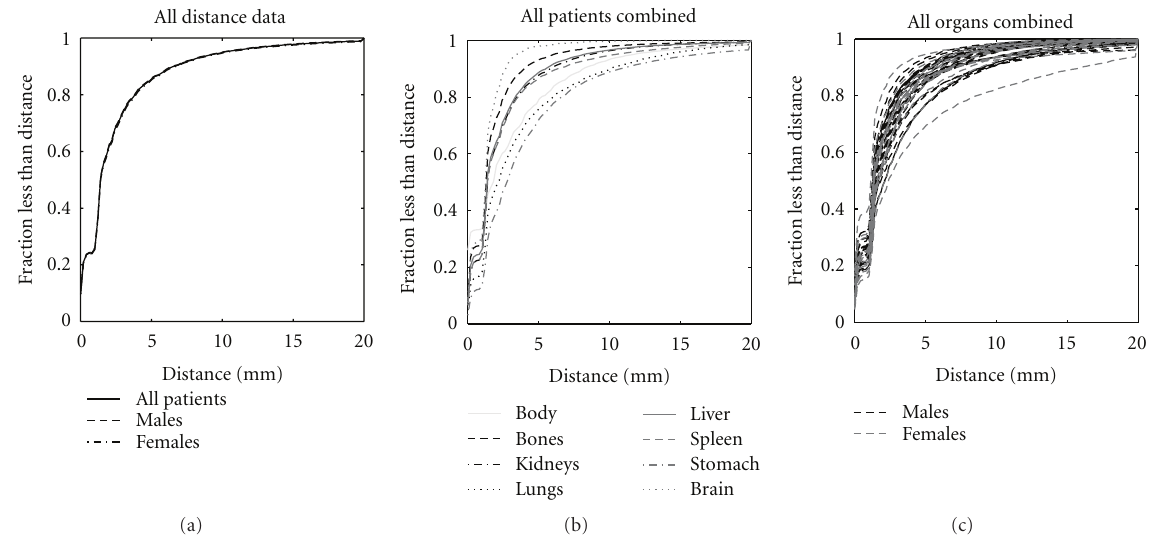
Figure 7: Cumulative distribution functions of final surface to surface distances are shown for all data and for all males and all females in (a), for individual organs with all patients combined in (b), and for individual patients with all organs combined in